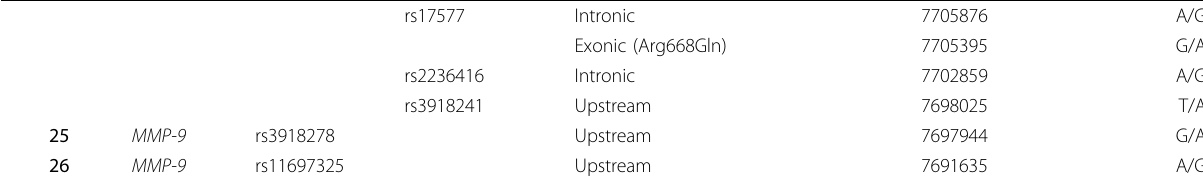
Table 4: SNPs selected for genotyping